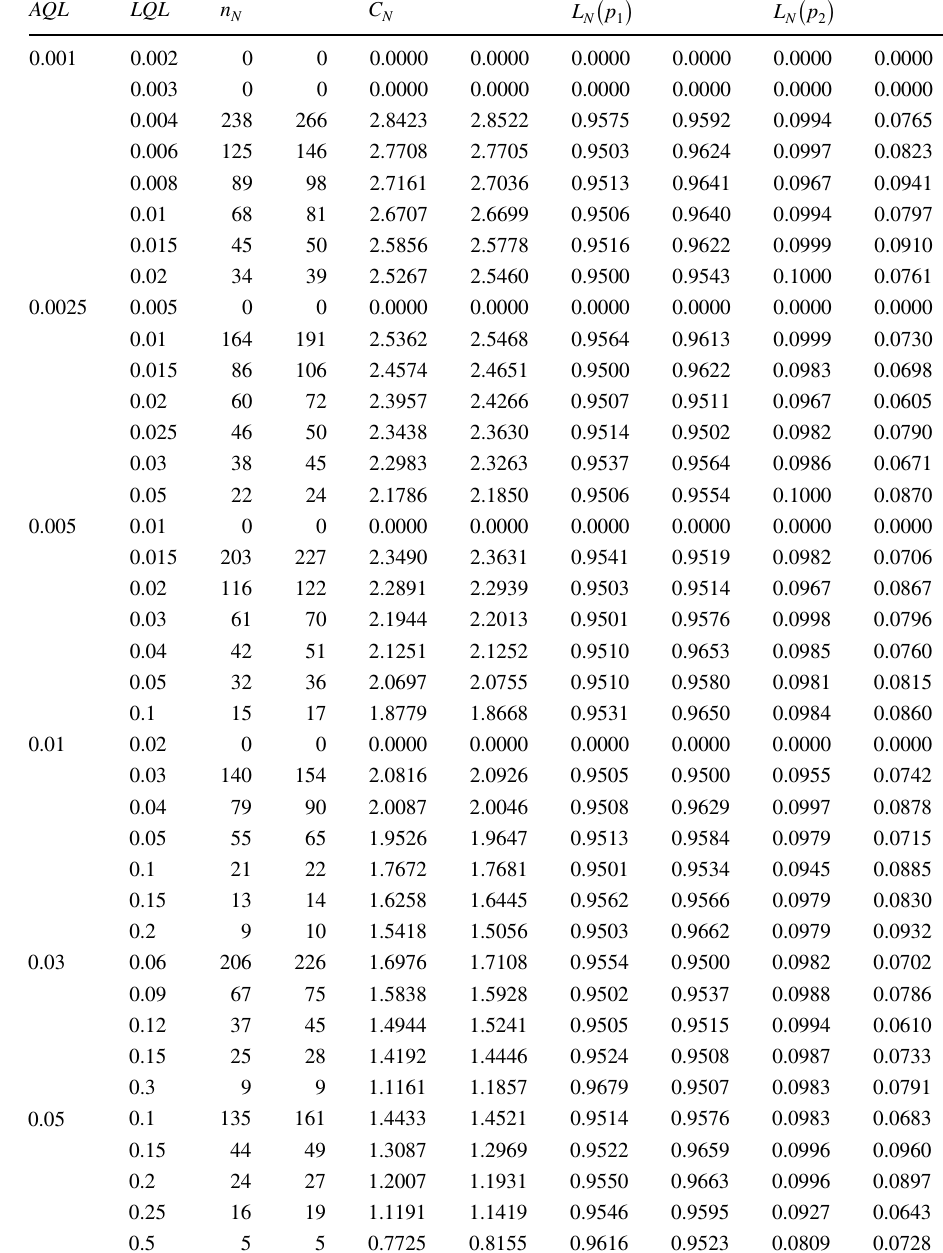
Table 5 Plan parameters for the existing neutrosophic plan, when 𝜎 Y N is unknown